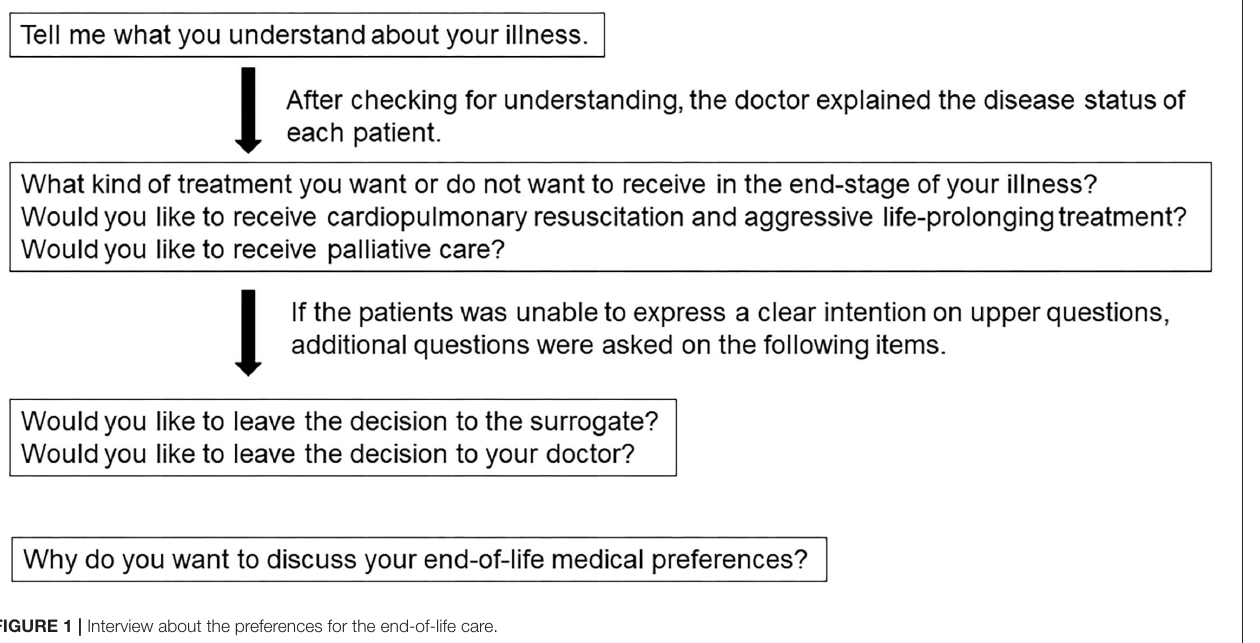
of Mini-Mental State Examination (MMSE) or administration of oral dementia